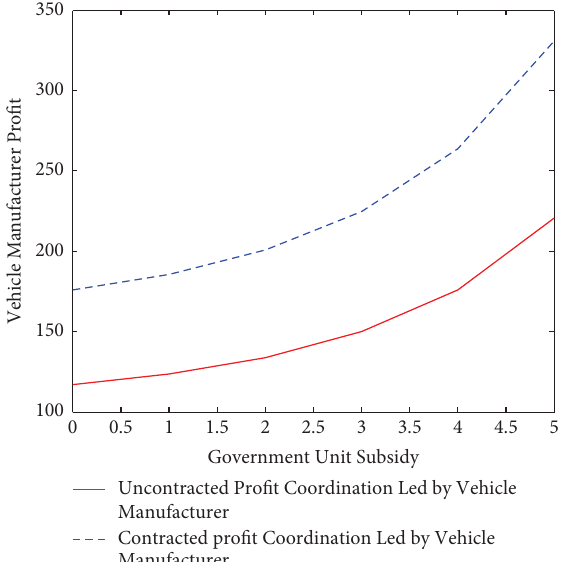
Figure 9: Te infuence of government subsidies before and after contract coordination on the proft of vehicle manufacturers when led by vehicle